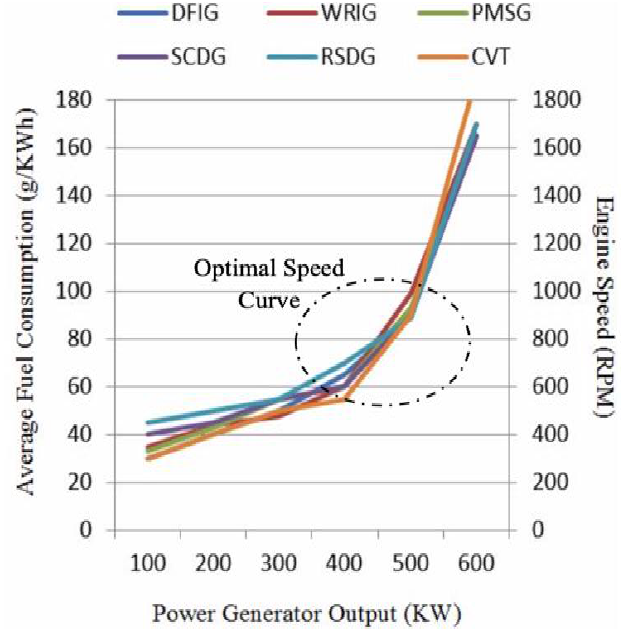
Figure 17. Comparison of combined fuel consumption comparison of VSDG (Grid-connected and Isolated communities) [7,40,129,130].